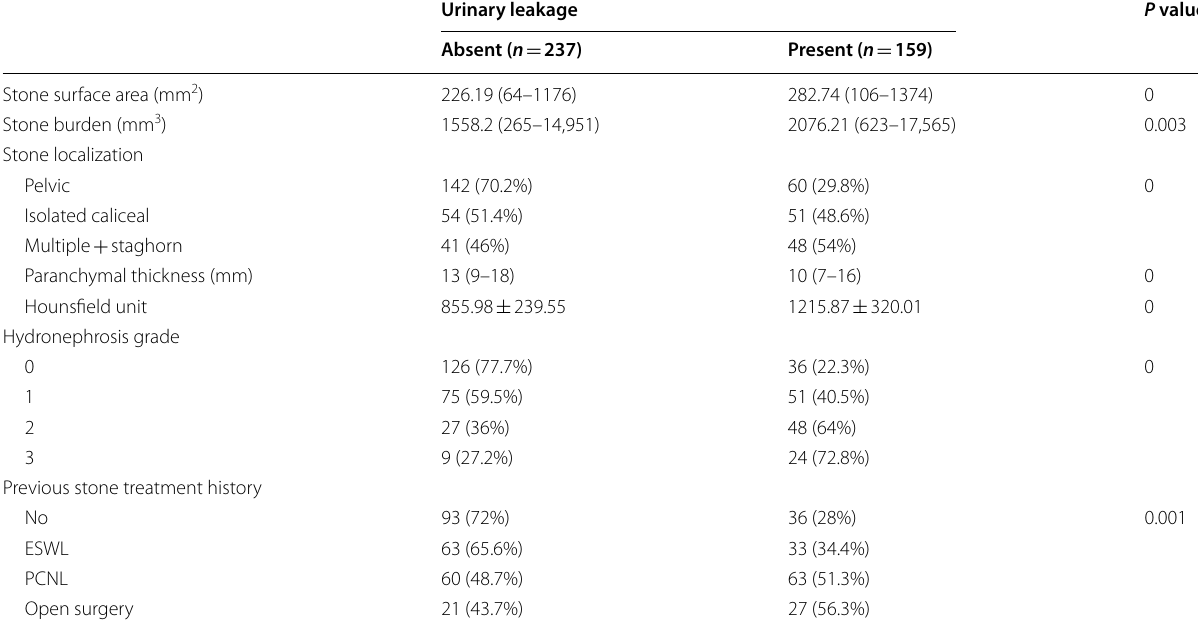
Table 2 The impact of kidney related factors and stone facts on urinary